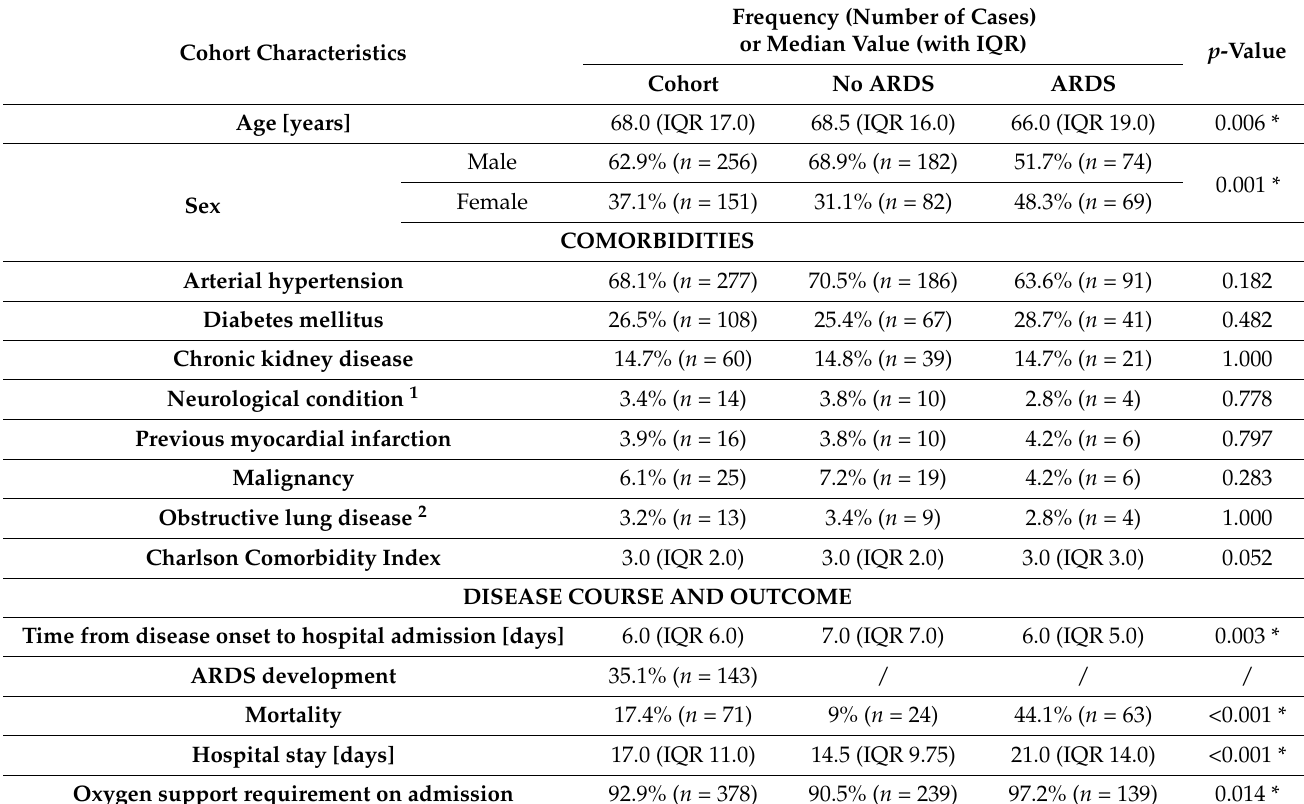
Table 2. Demographic and medical history data, with regard to ARDS